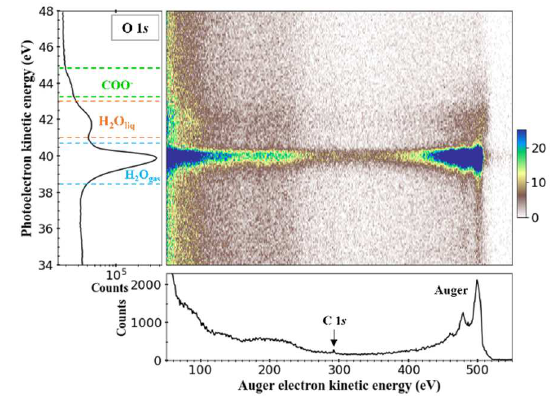
Fig. 2. Sodium benzoate two-dimensional coincidence map « Auger electron kinetic energy / photoelectron kinetic energy » (middle part). The photoelectron spectrum is shown on the left, with a step of 0.1 eV. The total (unfiltered) Auger electron spectrum (lower part, in black) is shown with a step of 1 eV.